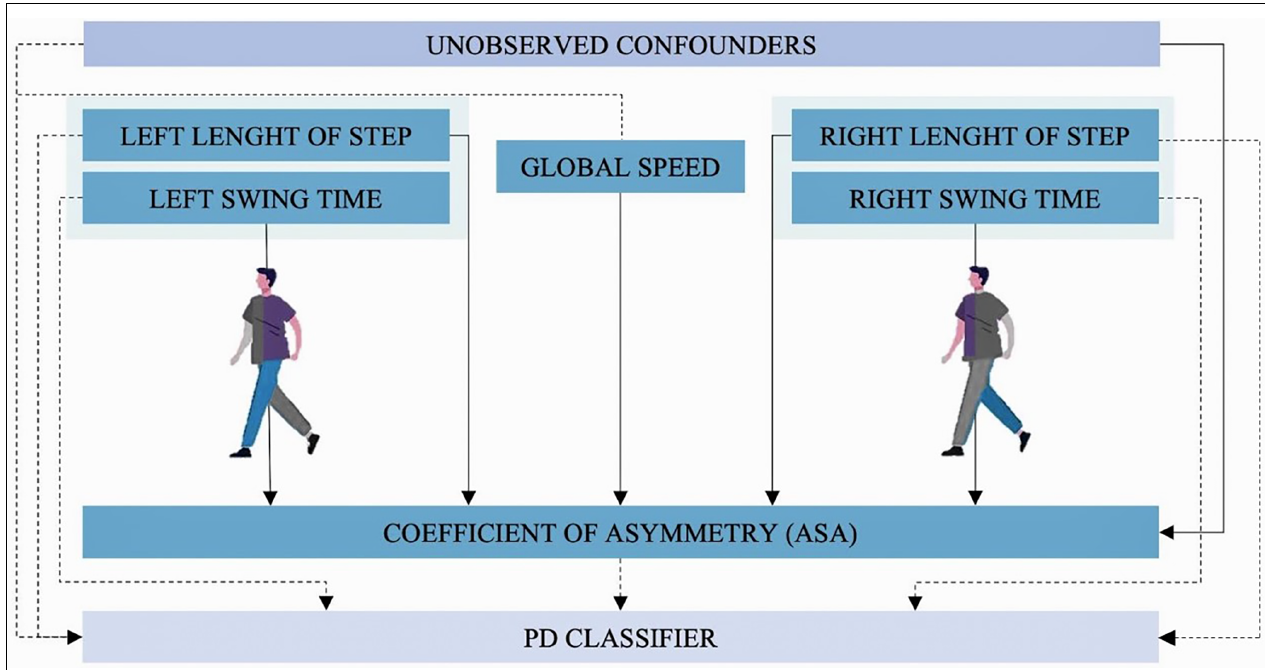
FIGURE 4 | Causal inference model. Dashed arrows show the causal relation identified by the model between leg and arms gait variables with the diagnosis of PD (PD-Classifier). Continued lines show the causal relations identified by the model between arms and legs gait variables.